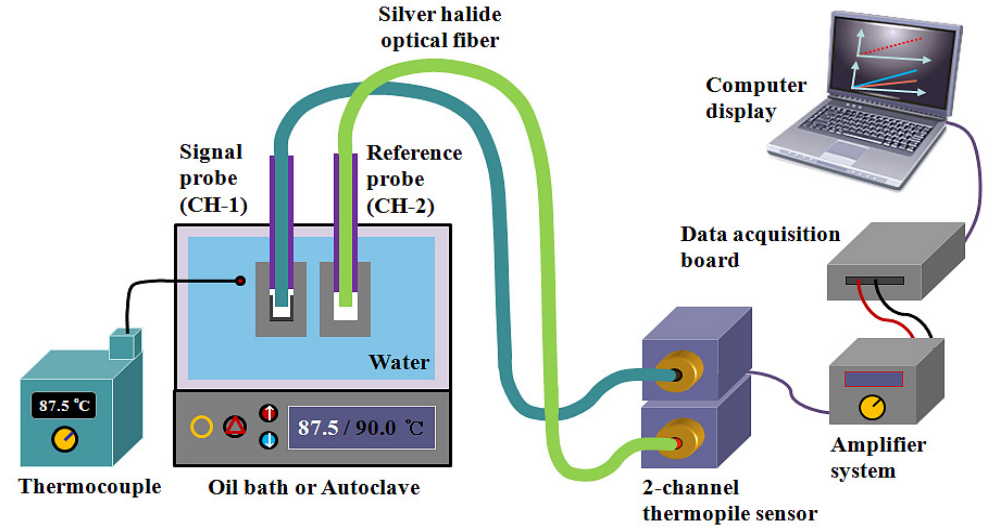
Figure 4. Experimental setup for measuring the temperature of the water using the embedded IR fiber-optic sensor.